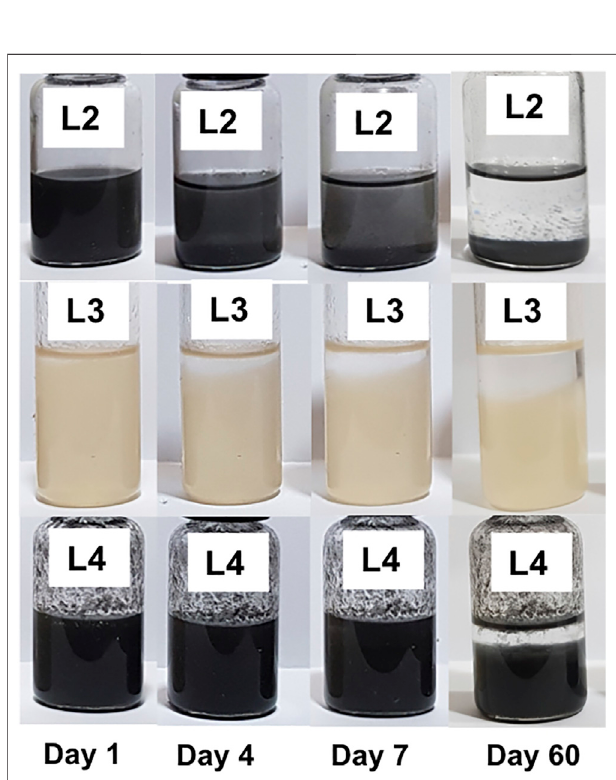
FIGURE 5 | Stability of the lubricant specimens; the lubricants were stored at ambient temperature.